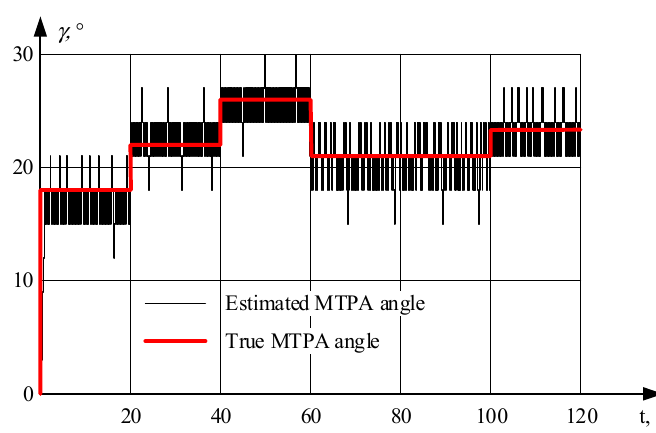
Figure 11. MTPA angle defined at 1500 rpm with N = 15.